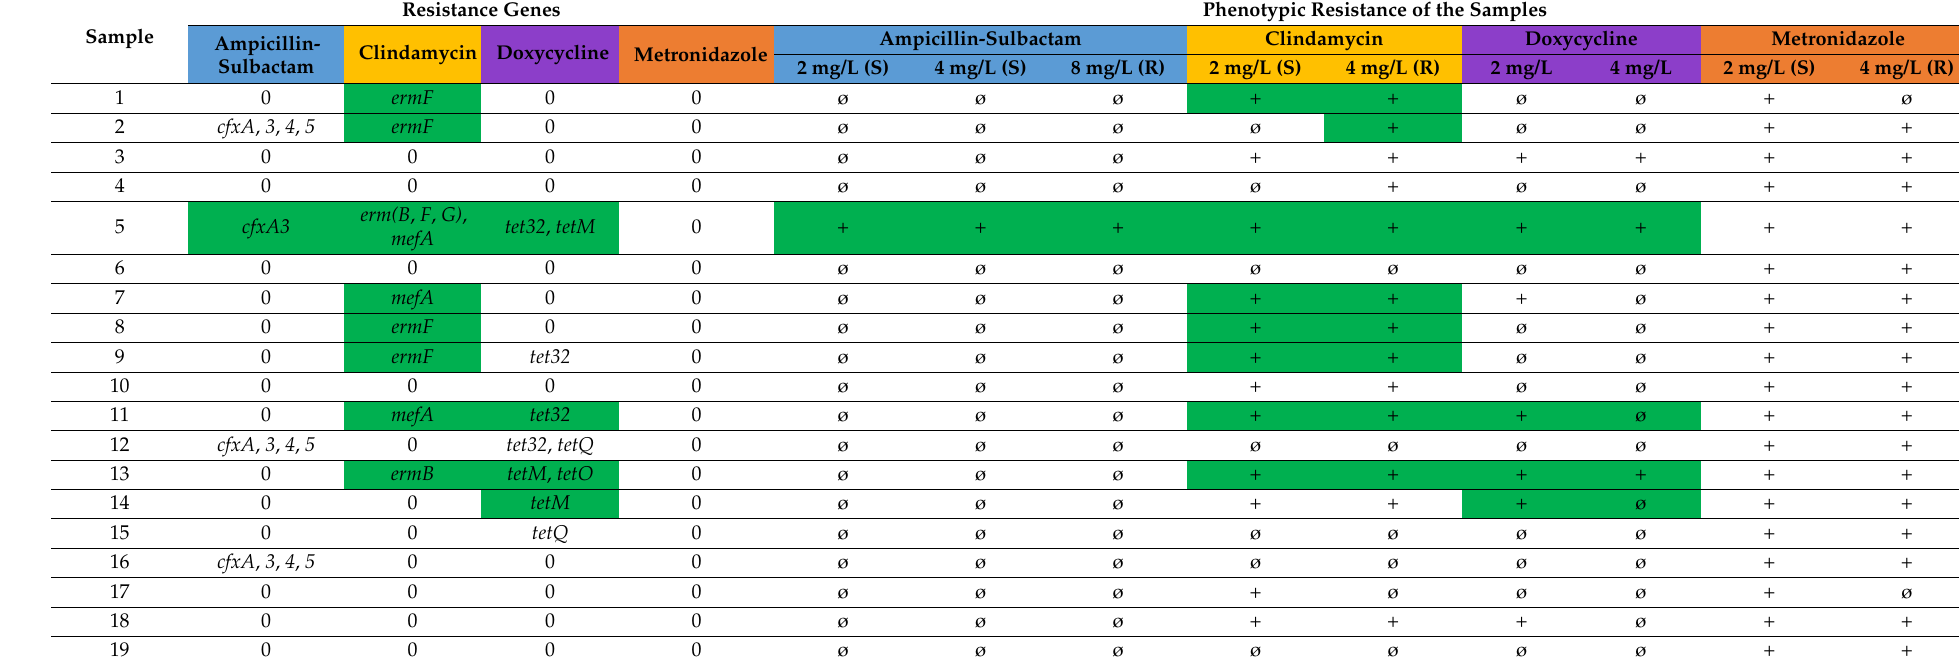
Table 6. Connection of resistance genes and phenotypic